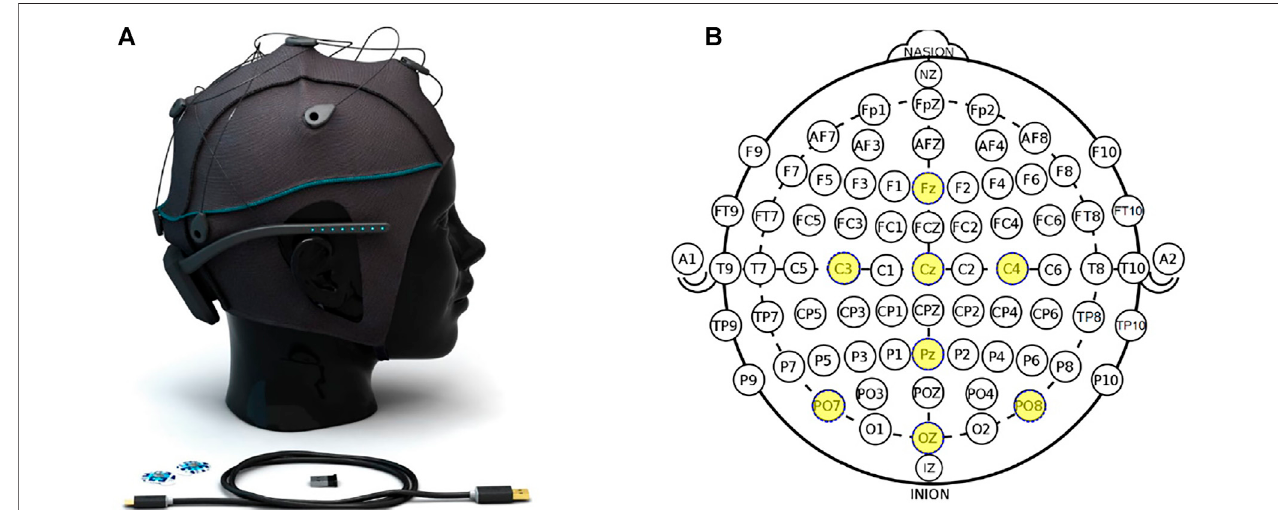
FIGURE 1 | (A) Unicorn Hybrid Black system, (B) the electrode positions of the system. Ground and reference are fi xed on the mastoids using disposable sticker- based surface electrodes and not visible in the graphic.